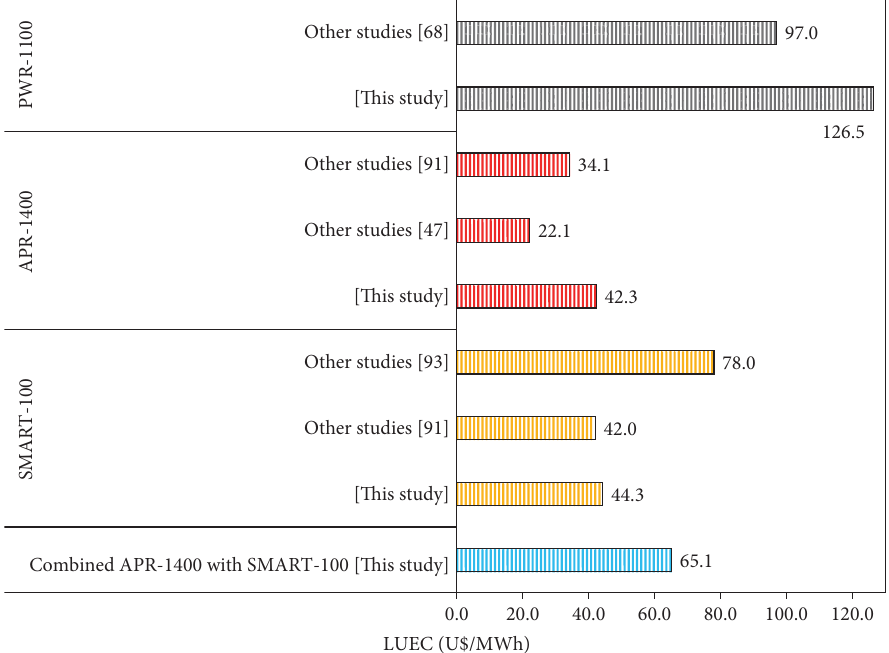
Figure 20: LUECs calculated for APR-1400, SMART-100, and the combined nuclear fleet with a ratio of number units of reactors (i.e., 20: 12 for APR-1400 to SMART-100 as predicted by MESSAGE tool at the end of 2050) along with the LUECs reported in previous